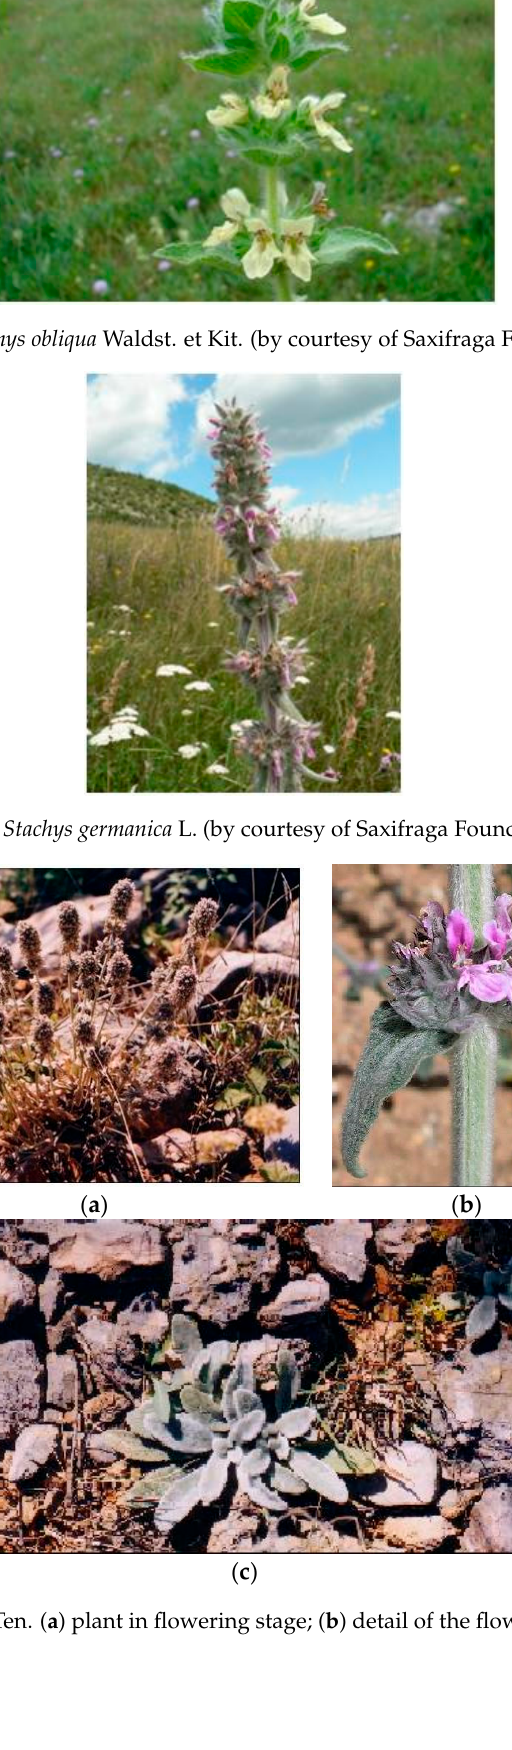
Figure 9. S. salviifolia Ten. ( a ) plant in flowering stage; ( b ) detail of the flower; ( c ) detail of leaf.